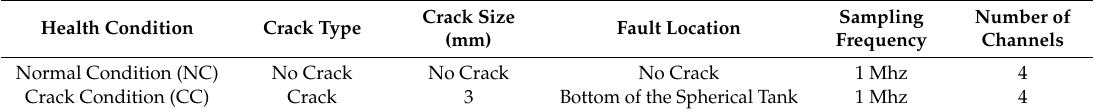
Table 3. Details of the health conditions considered for the